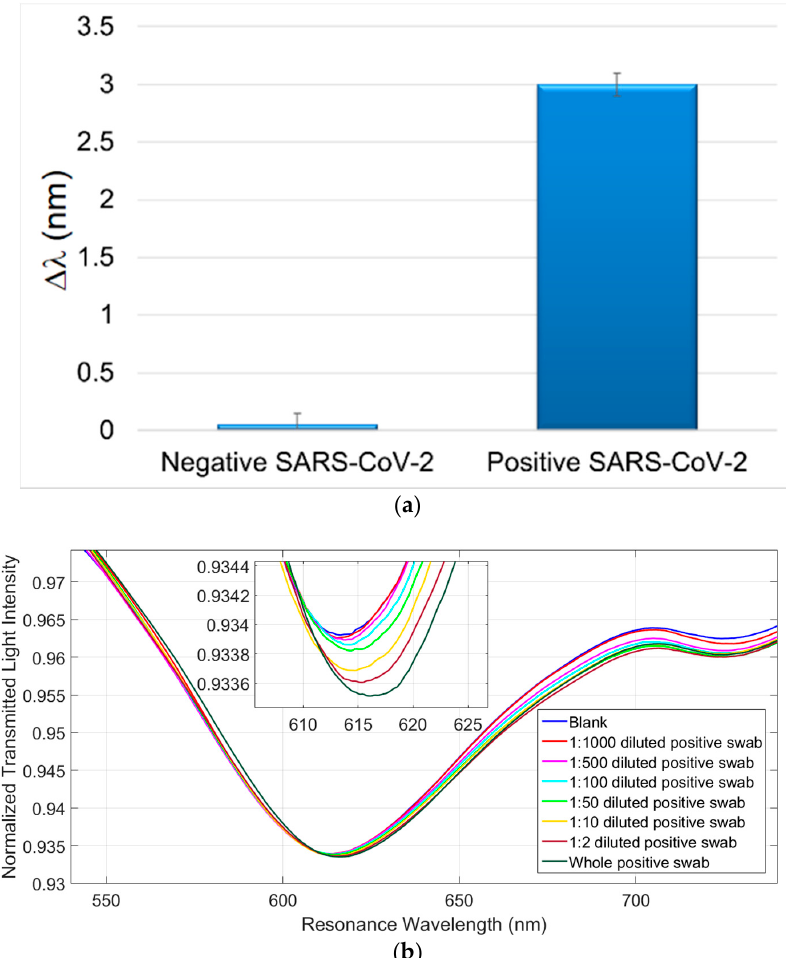
Figure 6. ( a ) Comparison of the response obtained by the MIP-SPR sensor with a negative SARS-CoV-2 swab (Physiological medium) and a positive SARS-CoV-2 swab (Physiological medium) (confirmed by RT-PCR). ( b ) Response curves of SARS-CoV-2 Positive swab (36th RT-PCR cycle) in physiological medium, at different dilutions, tested with SARS-CoV-2 MIP-sensor. The samples were diluted with physiological solution. Sensors 2021 , 21 , x FOR PEER REVIEW